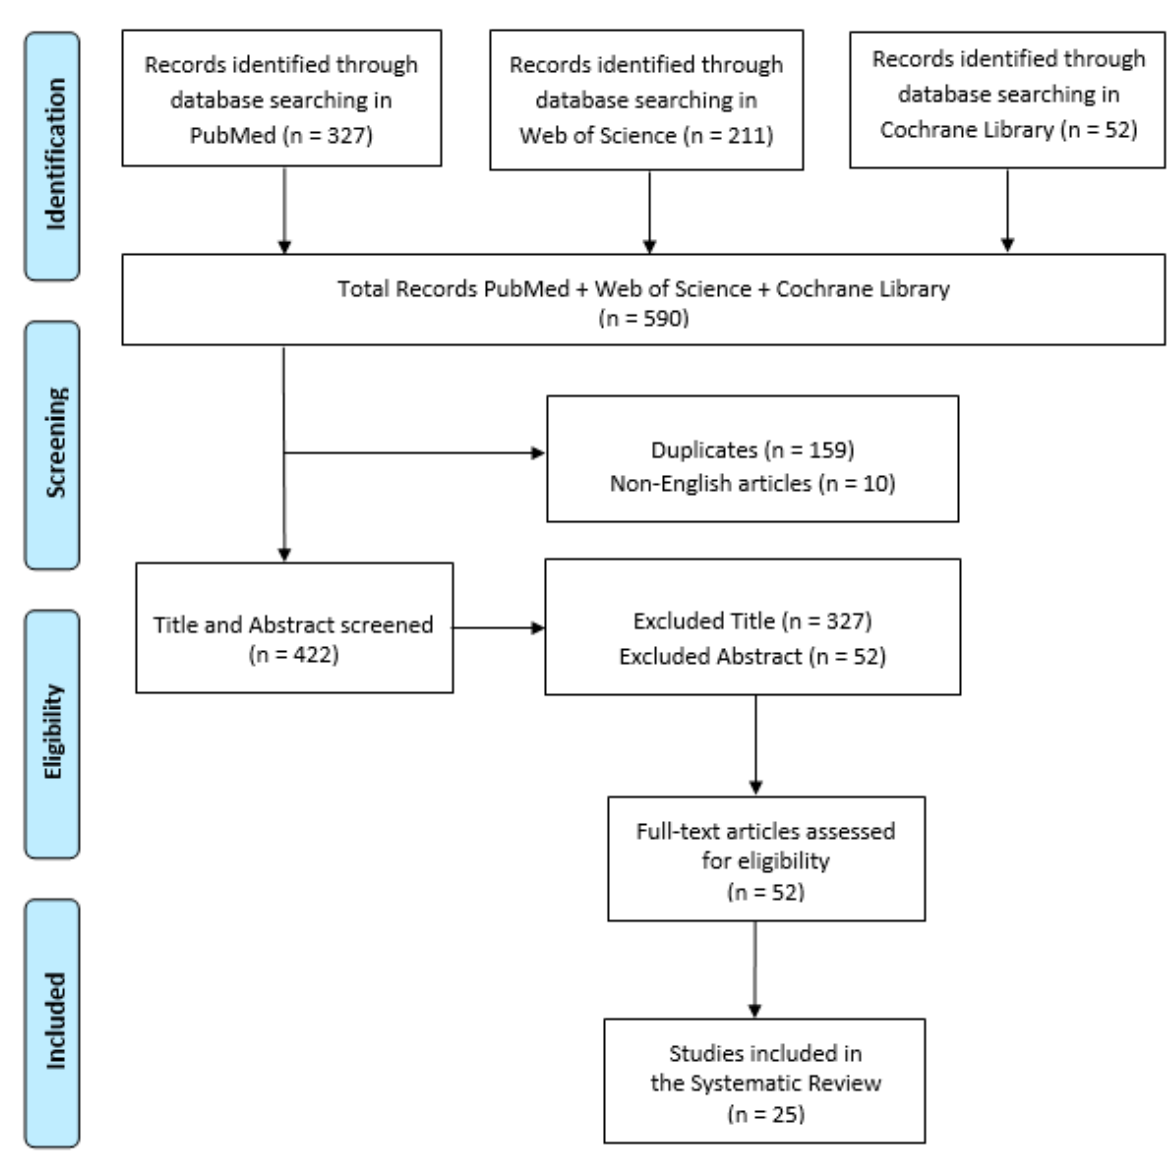
Figure 1. PRISMA flow chart for the current systematic review.